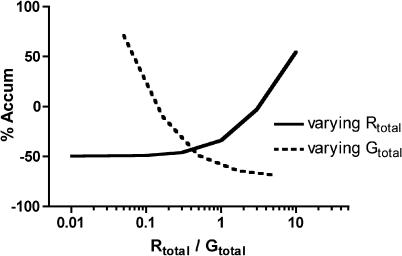
The Effect of the Ratio of Receptor to G Protein on G Protein ActivationRtotal was set at 5,000/cell and Gtotal varied (dashed line). As G protein expression increases, the response changes from negative to positive agonism. Gtotal was set at 100,000 per cell and Rtotal varied (solid line). As receptor expression increases, the response changes from negative to positive agonism.